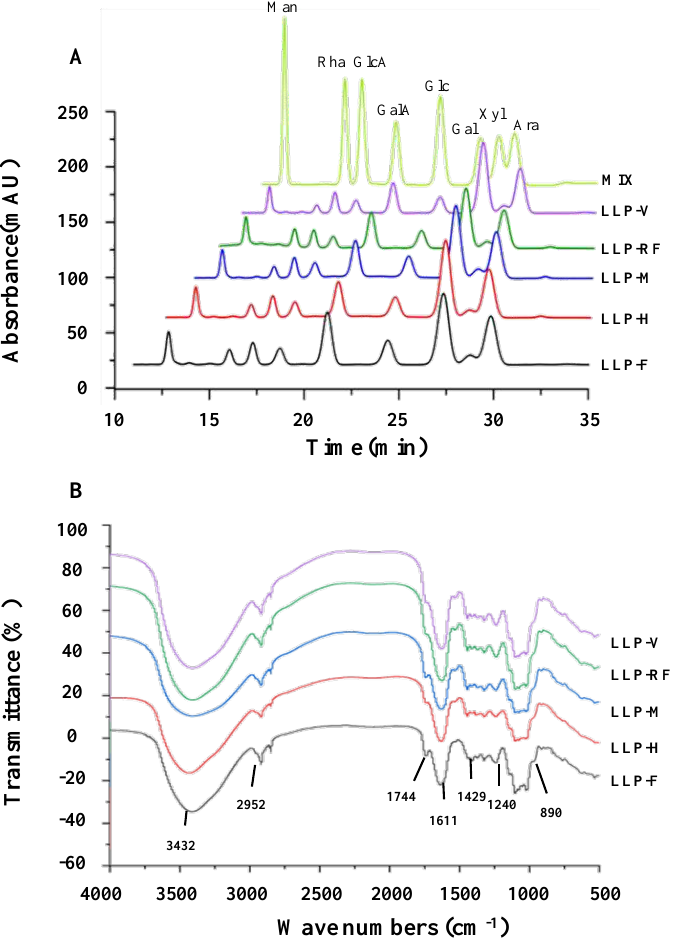
Figure 2. HPLC profiles of constituent monosaccharides ( A ) and FT-IR spectra ( B ) of LLPs. The sample codes were as presented in Table